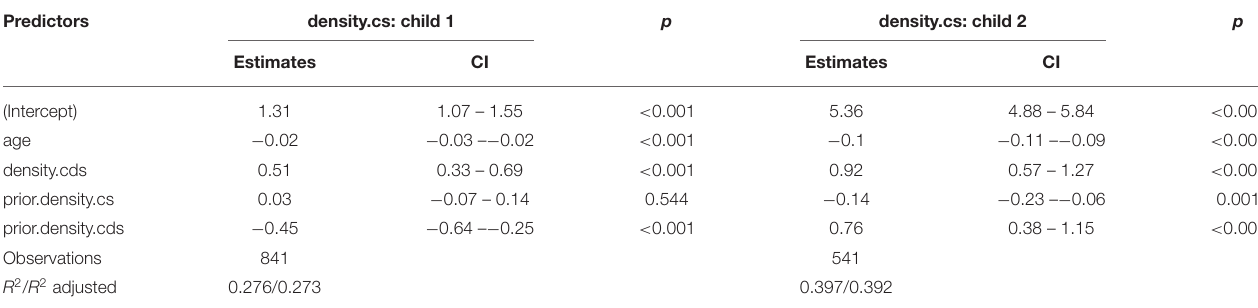
TABLE 10 | Linear model: CS Network density.